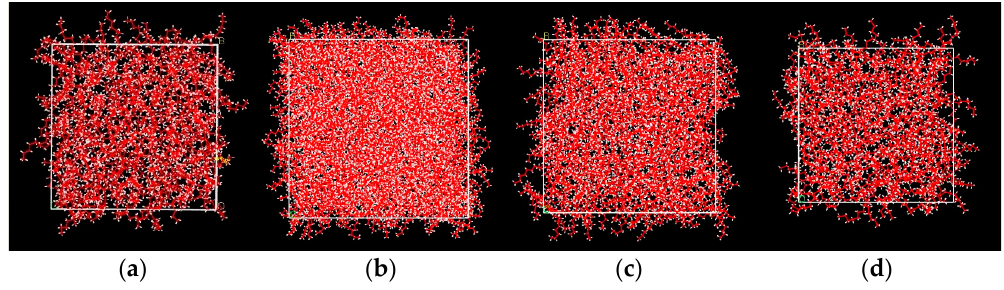
Figure 3. Initial configuration of systems. ( a ) 128 n -octadecane molecules; ( b ) 1 Cu nanoparticle and 512 n -octadecane molecules; ( c ) 1 Cu nanoparticle and 256 n -octadecane molecules; ( d ) 1 Cu nanoparticle and 128 n -octadecane molecules.